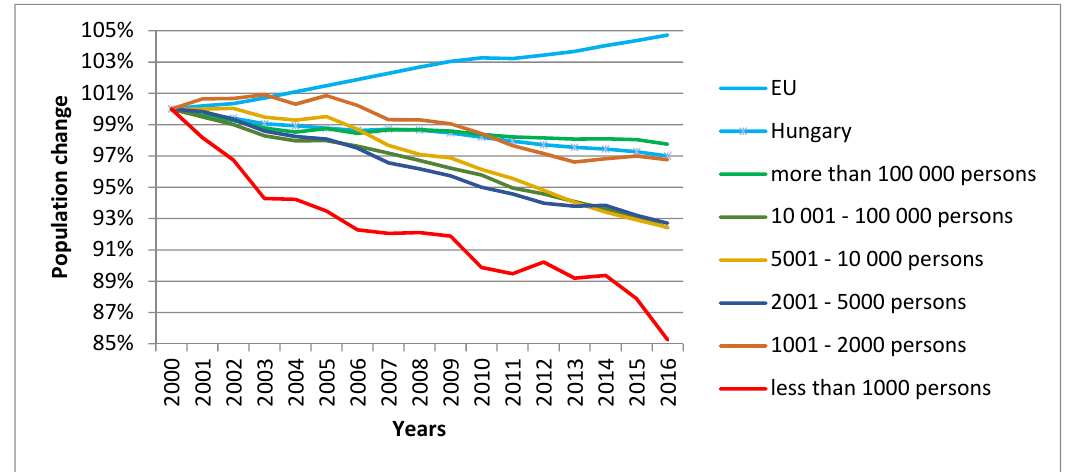
Figure 4. Population change compared with the value of the year 2000 in a population number breakdown [authors’ edition based on the Hungarian National Statistic Authority (KSH) database].